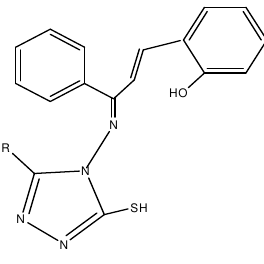
Figure 1. 2-{(1 E ,3Z)-3-[(5-mercapto-3-Phenyl/Pyridyl-4 H -1,2,4-triazol-4-yl)imino]-3-